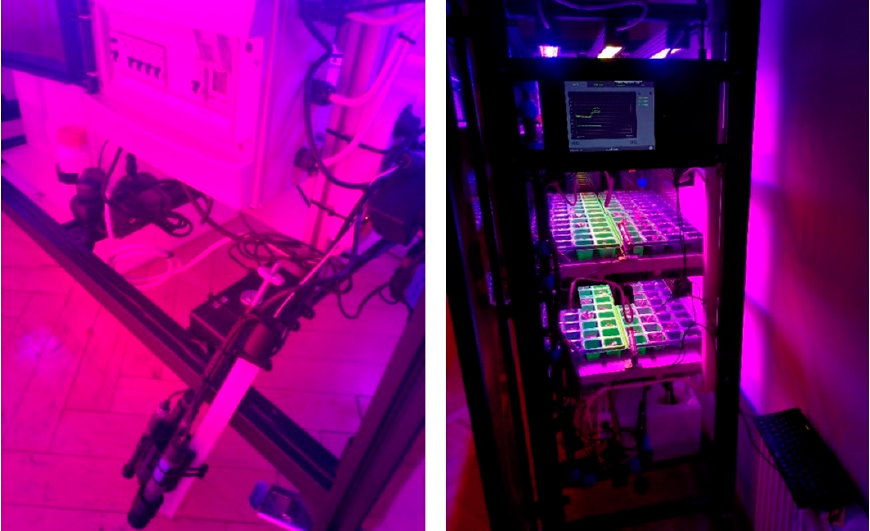
Figure 3. Monitoring unit, sensors for temperature, humidity, pH, EC and the irrigation control cabinet ( left ) and the user interface ( right ) (Photos: Cichocki 2020).